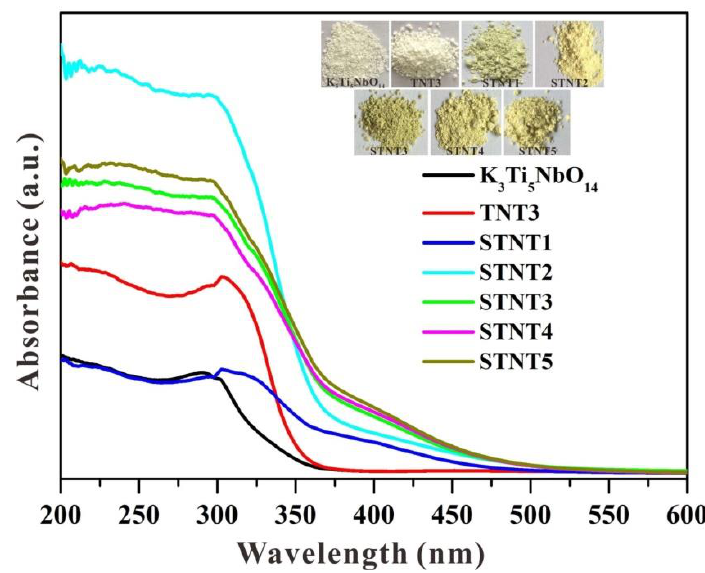
Figure 5. UV-visible diffuse reflectance spectra of as-prepared photocatalysts (Inset is the images of the corresponding samples).